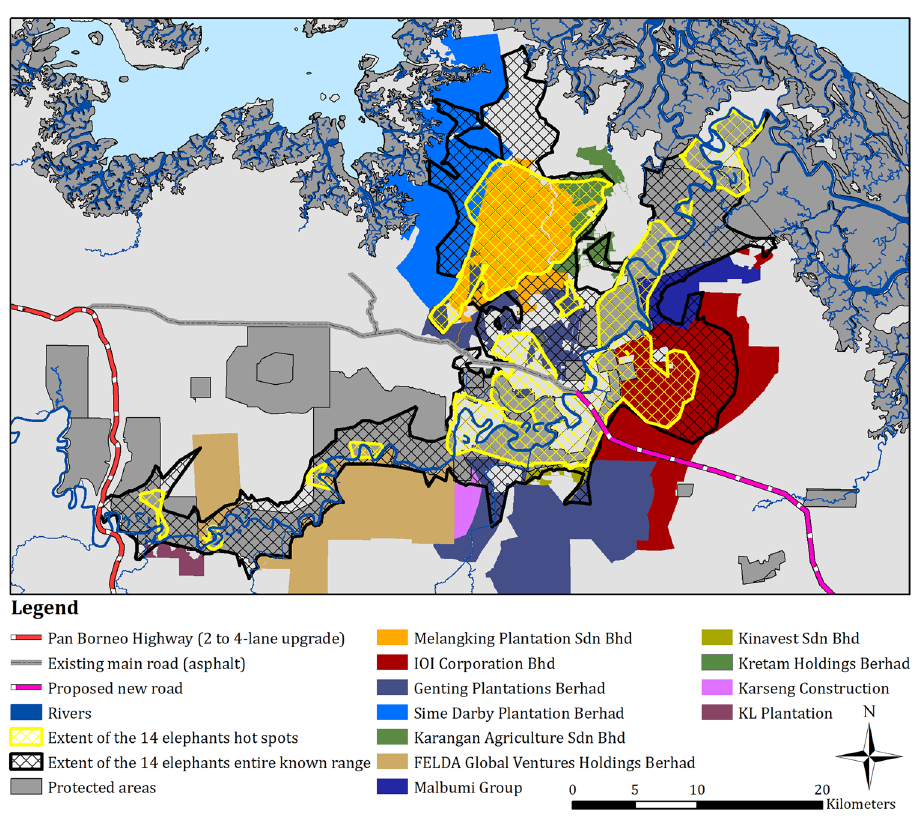
Figure 4. Map showing the pooled extents for hot spots (yellow cross hatch) and entire range (black cross hatch) within identified oil palm estates within the Lower